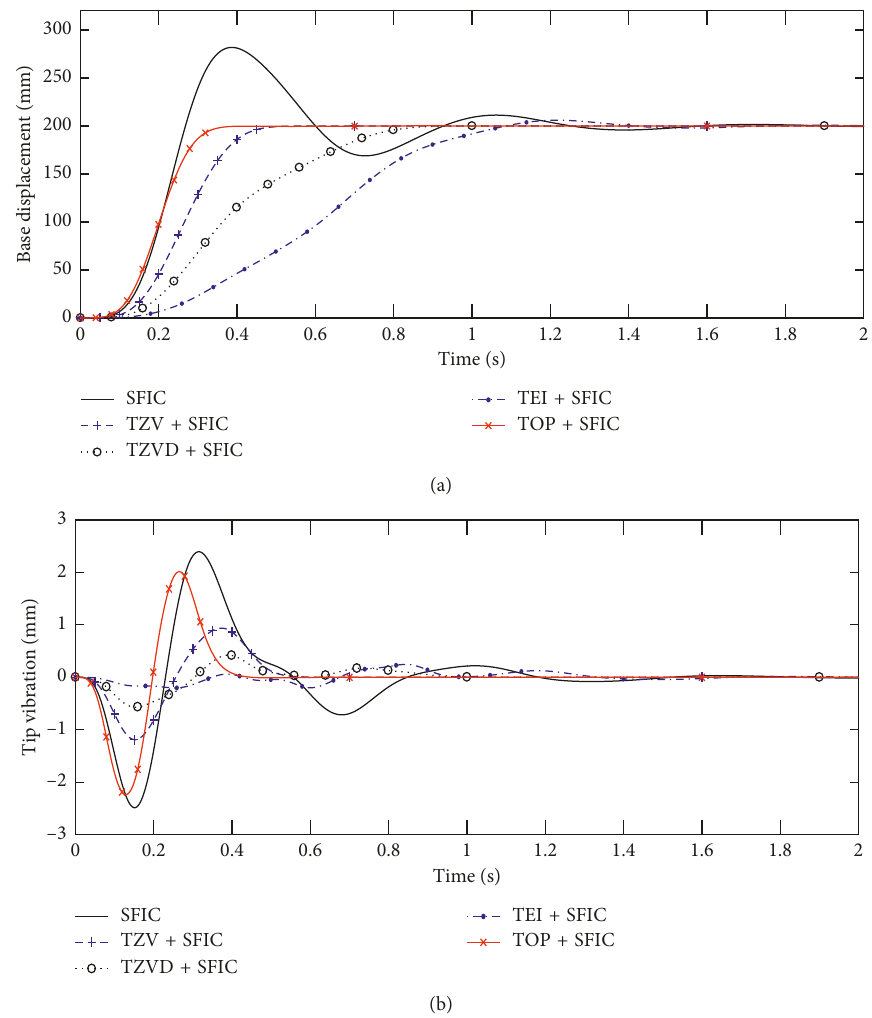
Figure 6: Control effect of the SFIC with different input shapers combined on the TFMS: (a) control effect of the base displacement; (b) control effect of the elastic